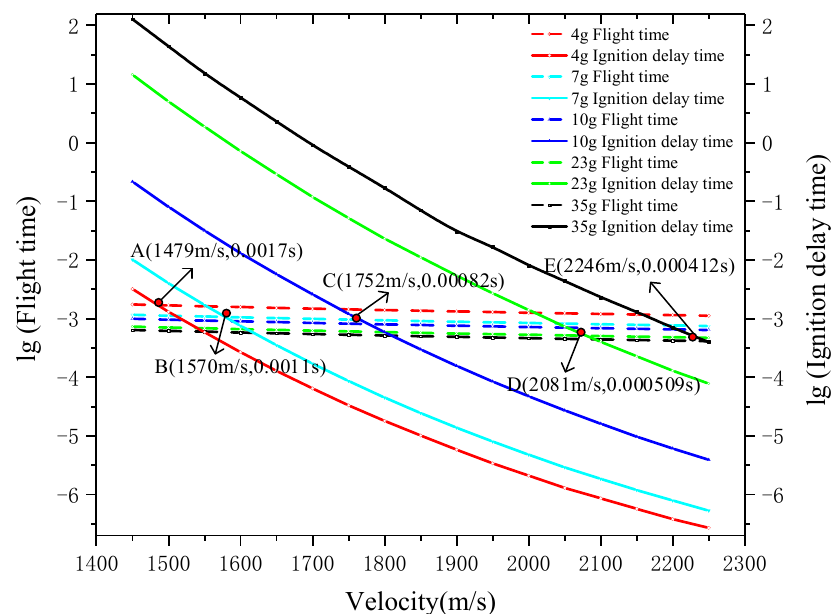
Figure 15. Comparison of flight time and ignition delay time with different velocities and masses of Inert